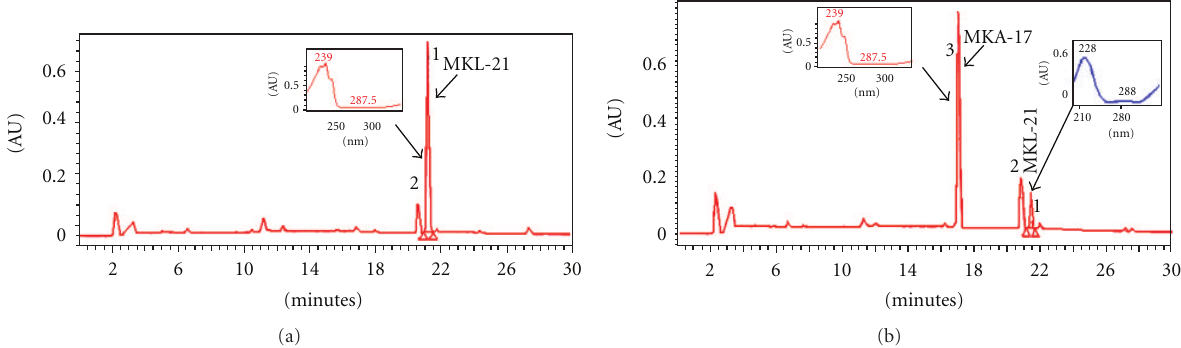
Figure 3: HPLC chromatogram with UV spectra of the supplement-fermented Monascus purpureus RYR (commercial product). (a) RYR HPLC chromatogram profile with UV spectrum before lactonization and (b) after lactonization. MKL: monacolin K lactone form, MKA: monacolin K acid form.